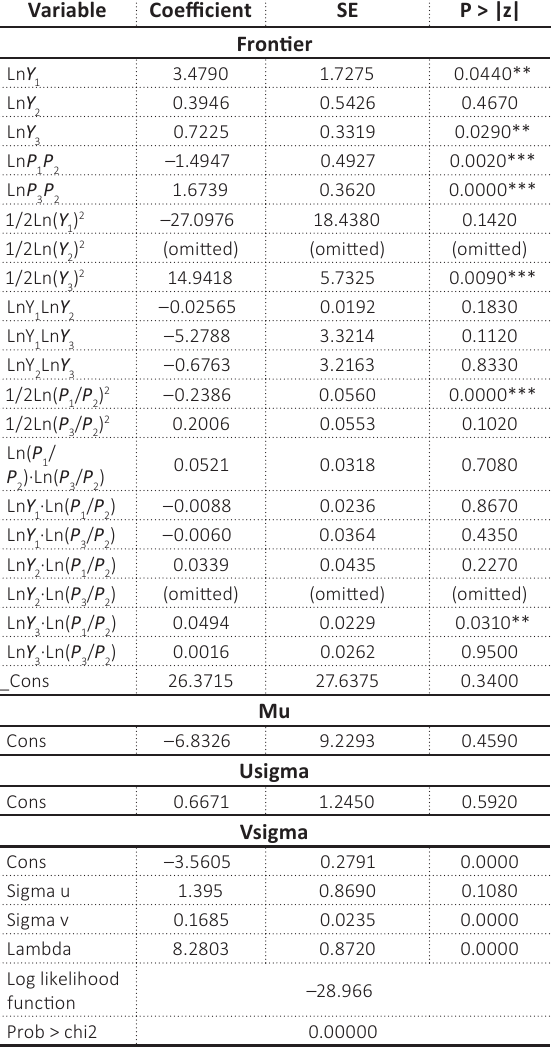
Table 4. Results of the stochastic cost frontier